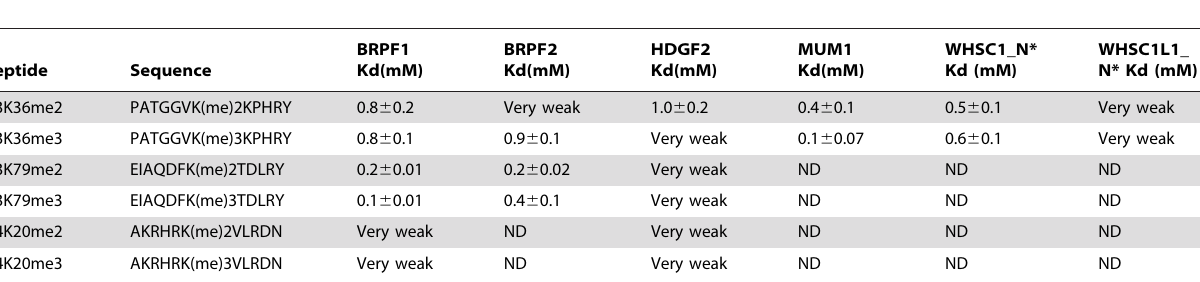
Table 1. Binding affinities of human PWWP domains for histone H3 and H4 methylated peptides.